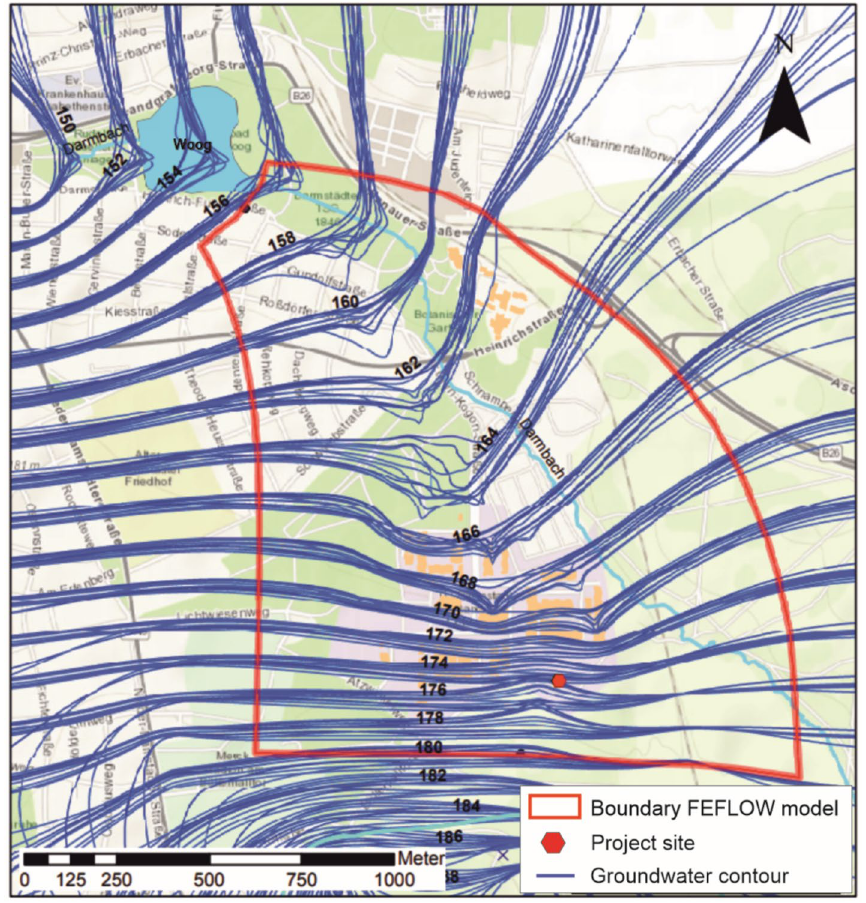
Fig. 4 Average groundwater contour lines for each month for the period 2000–2020. In red the FEFLOW model boundary, derived from the groundwater flow